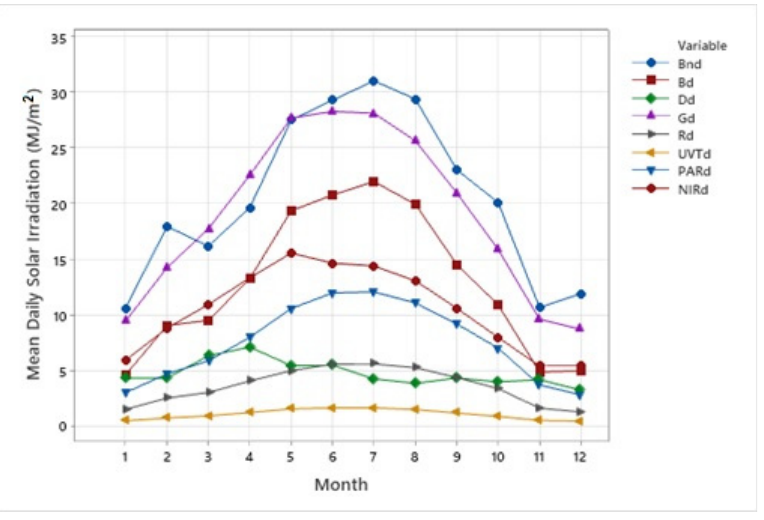
Figure 25. Monthly mean daily values (MJ/m 2 ) for all radiation components.